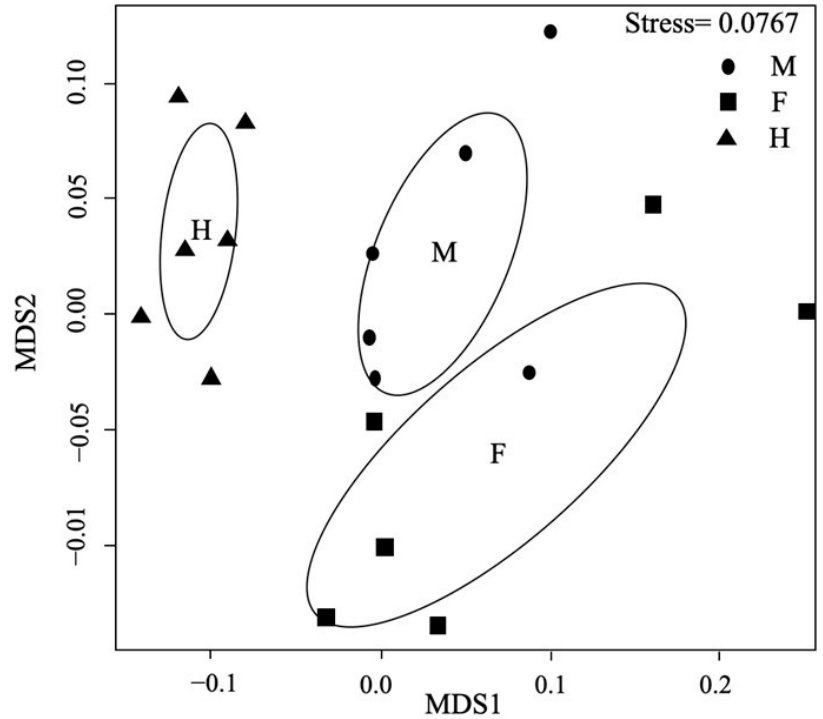
Figure 3. Nonmetric multidimensional scaling (NMDS) of Eurya loquaiana floral scent composition. Male (M), female (F), and hermaphrodite (H) flowers were tested.